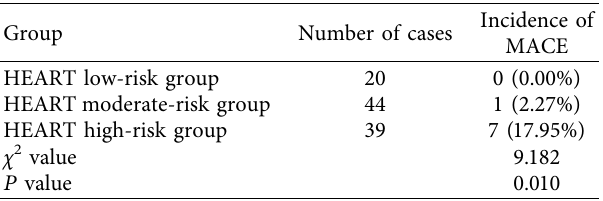
Table 2: Occurrence of 30d MACE in patients with diferent HEART scores.